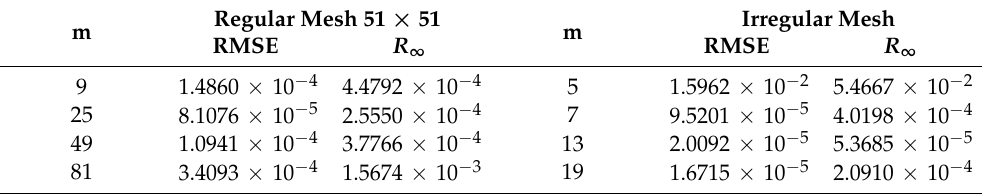
Table 3. Example No. 1—comparison of RMSE and R ∞ for different numbers of supporting points.